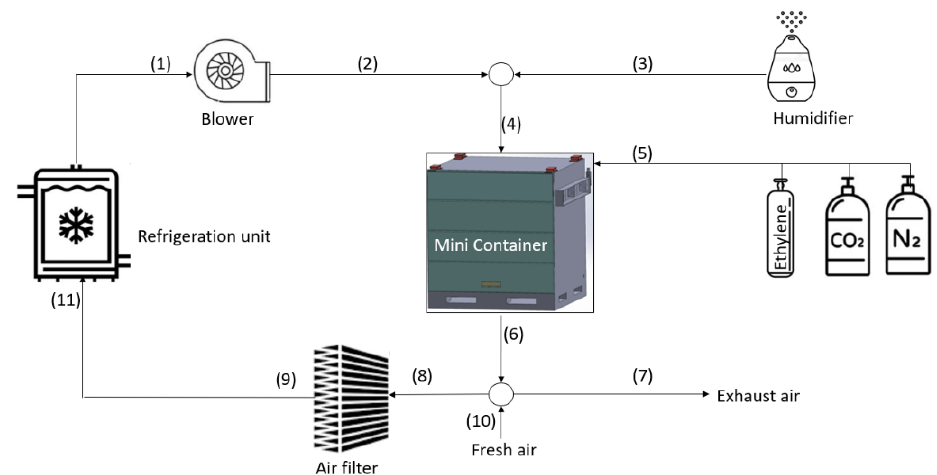
Figure 4. Basic sketch of the mini container (MC) system.